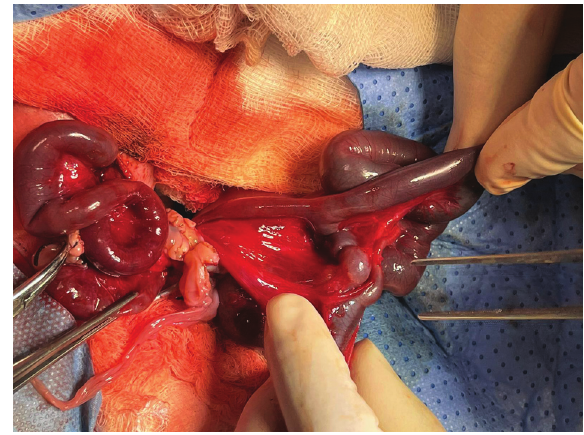
Fig. 2 An intraoperative image demonstrating the small bowel of baby 1 ending distally in the anti-mesenteric boarder of the terminal ileum in Baby 2.